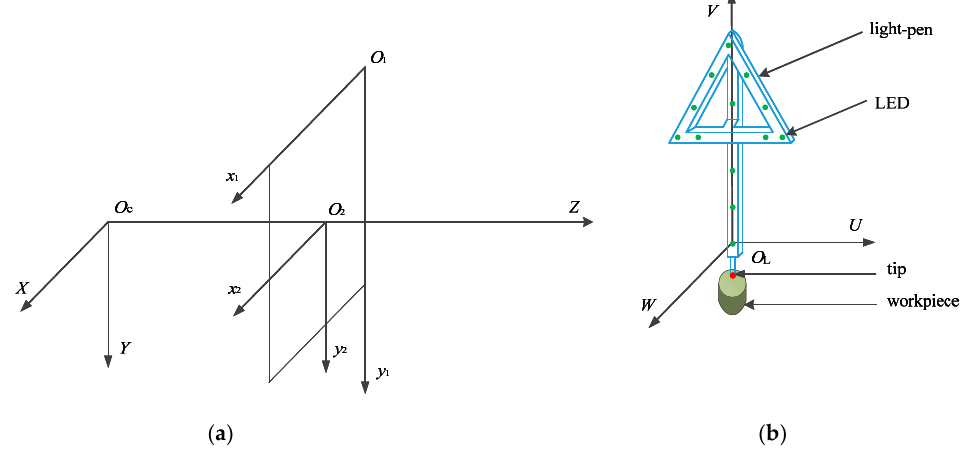
Figure 3. Four coordinate systems of the LPCMM. ( a ) Coordinate systems in the camera; ( b ) Coordinate system in the light-pen.